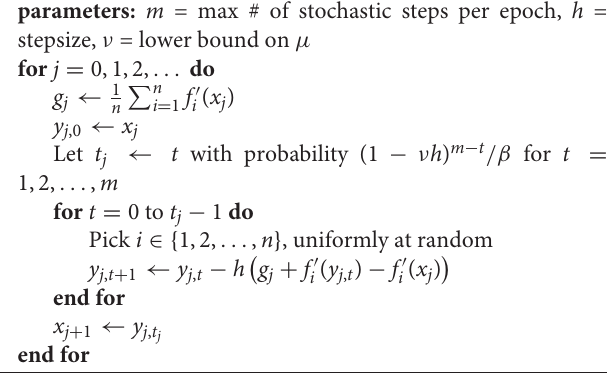
Algorithm 1 Semi-Stochastic Gradient Descent